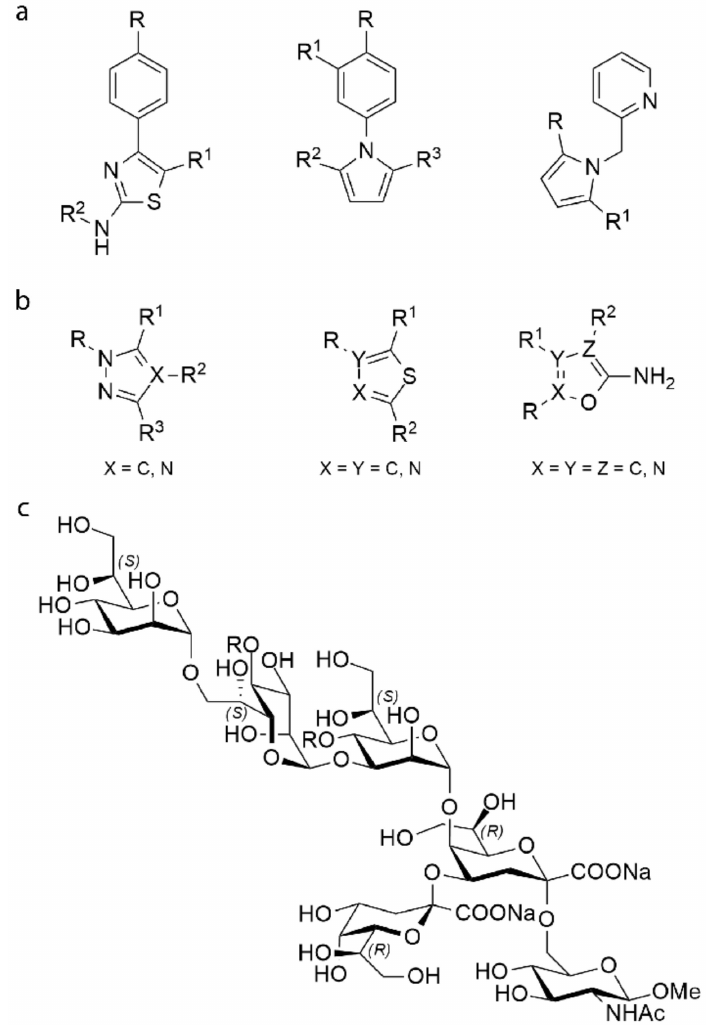
Figure 3. Chemical backbone structure of the ligands from library A ( a ) and B ( b ); in the carbohydrate- based library C ( c ) R = HPO 3 Na. Figures S1–S5 report all ligands of libraries A, B and